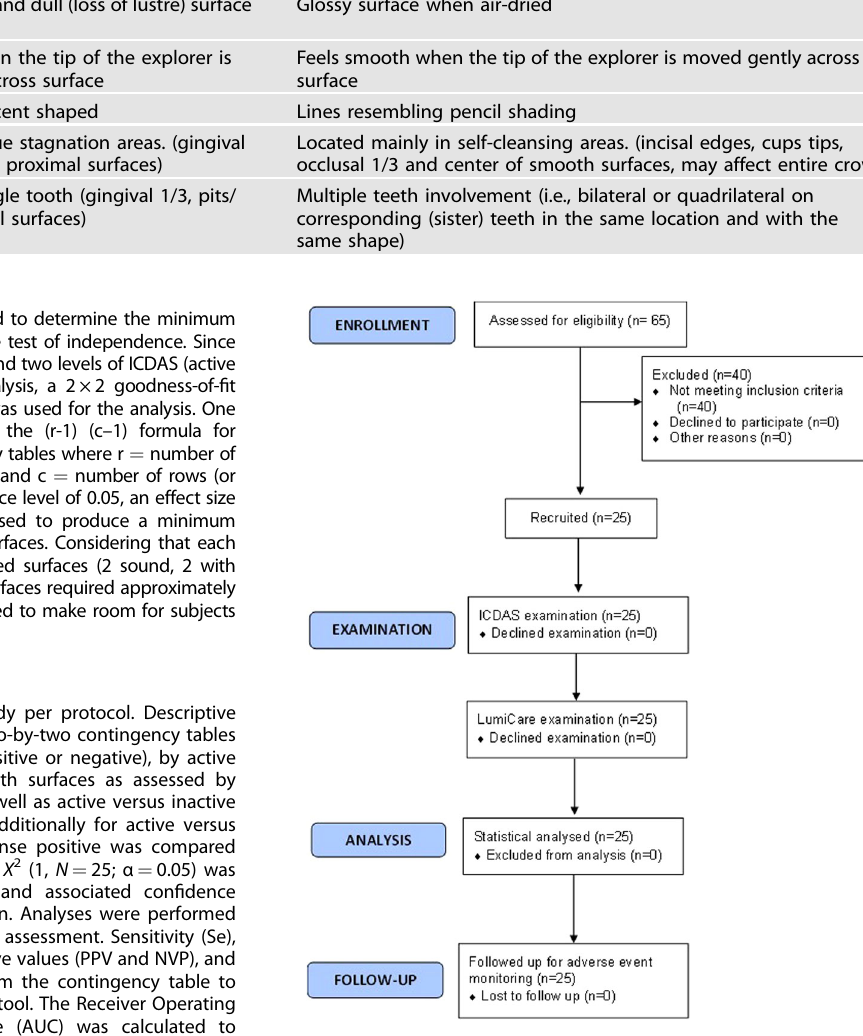
Fig. 2 A fl ow diagram representing the study